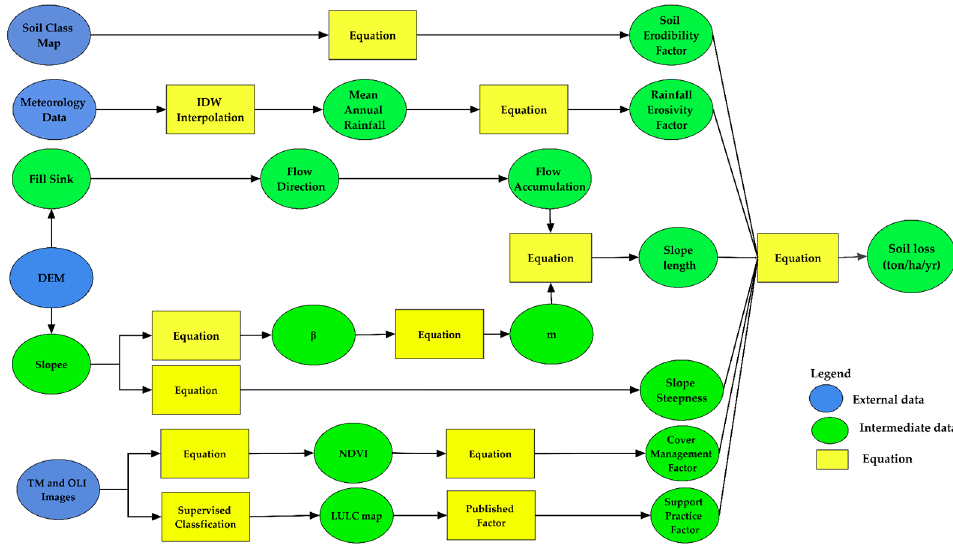
Figure 2. Flowchart for the soil loss estimation using the Revised Universal Soil Loss Equation (RUSLE) model framed in the ArcGIS model-builder interface.